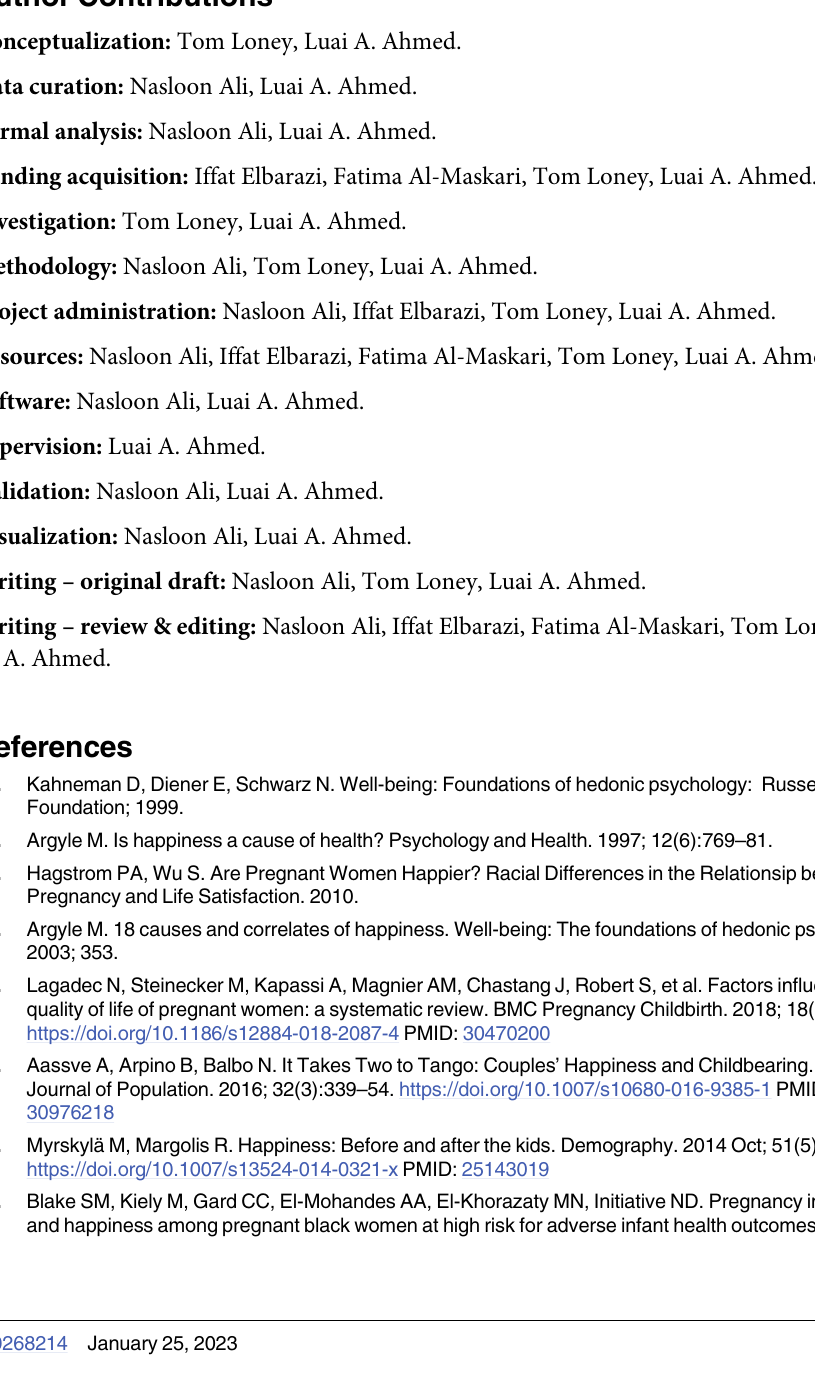
S4 Table. Crude and adjusted associations between sociodemographic and pregnancy- related factors and self-reported levels of happiness (tertiles) in pregnant women in Al Ain, UAE. The Mutaba’ah Study. S5 Table. Crude and adjusted associations between sociodemographic and pregnancy- related factors and self-reported levels of happiness (as a continuous table) in pregnant women in Al Ain, UAE. The Mutaba’ah